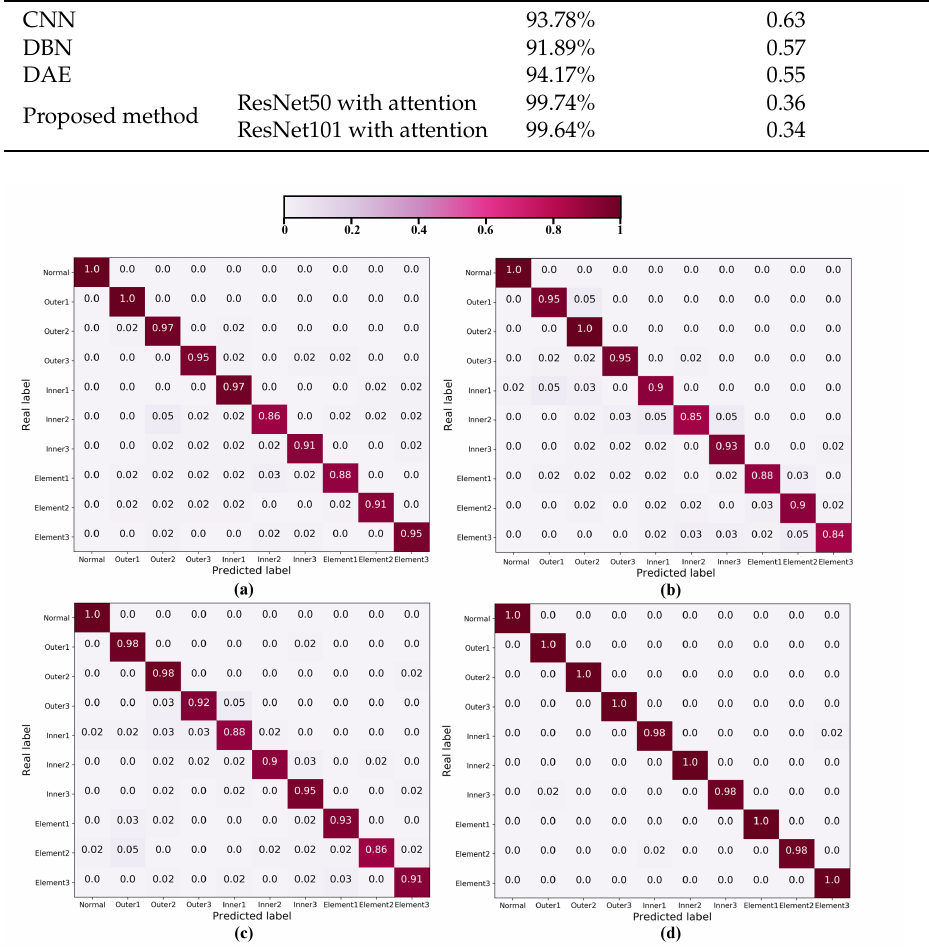
Figure 10. Confusion matrix of the fault detection result. ( a ) CNN; ( b ) DBN; ( c ) DAE; ( d ) Proposed method (ResNet50 with